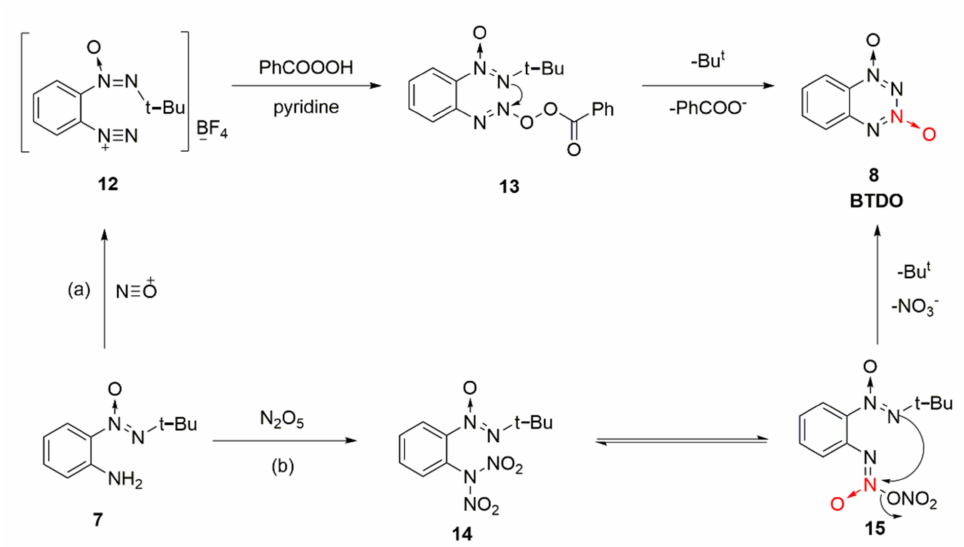
Scheme 2. Different reaction mechanism ( a ) and ( b ) of BTDO.